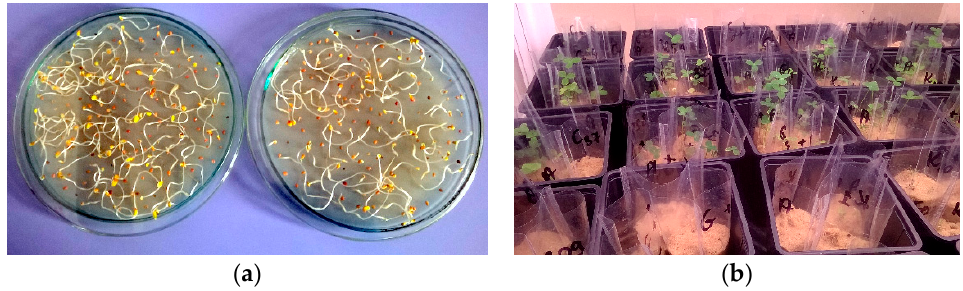
Figure 1. Biotest with clover: ( a ) growing clover sprouts on Jensen’s medium (1942) [44] before planting in sand; ( b ) clover growth on sand contaminated with PAH and inoculated with bacteria.